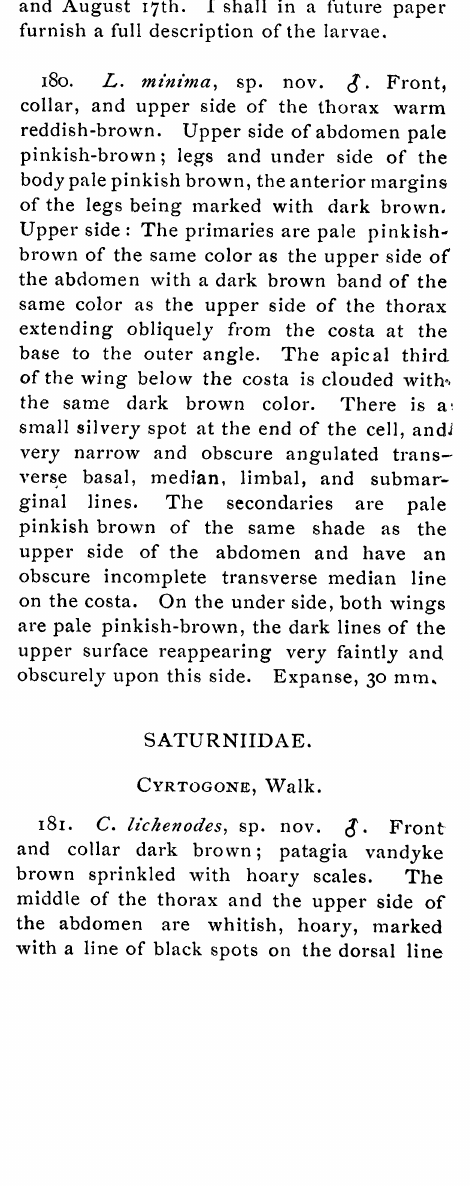
middle of the thorax and the upper side of the abdomen are whitish, hoary, marked with a line of black spots on the dorsal